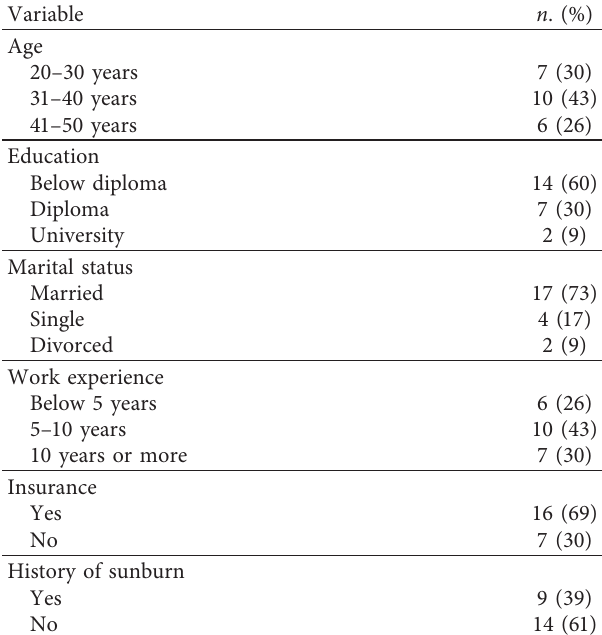
Table 1: Sailors’ demographic